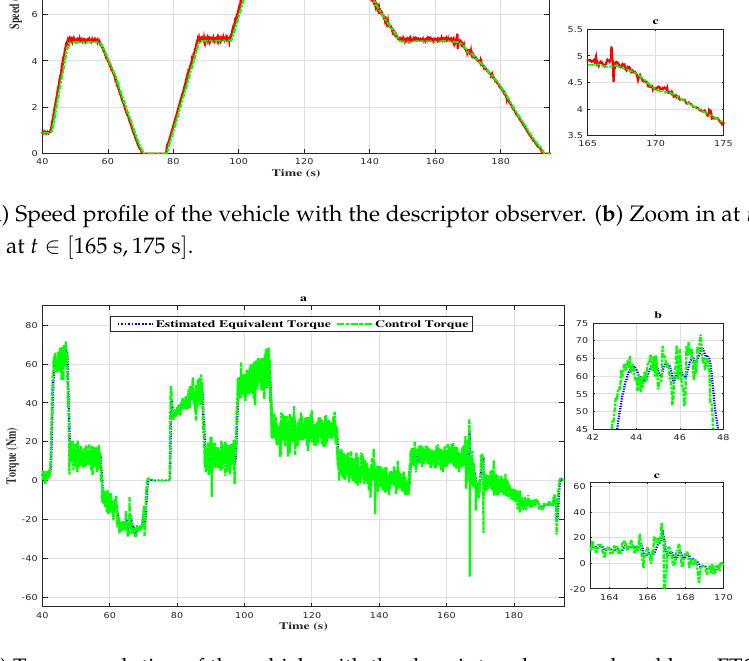
Figure 6. ( a ) Torque evolution of the vehicle with the descriptor observer closed loop FTC. ( b ) Zoom in at t ∈ [ 42 s,48 s ] . ( c ) Zoom in at t ∈ [ 163 s,170 s ]